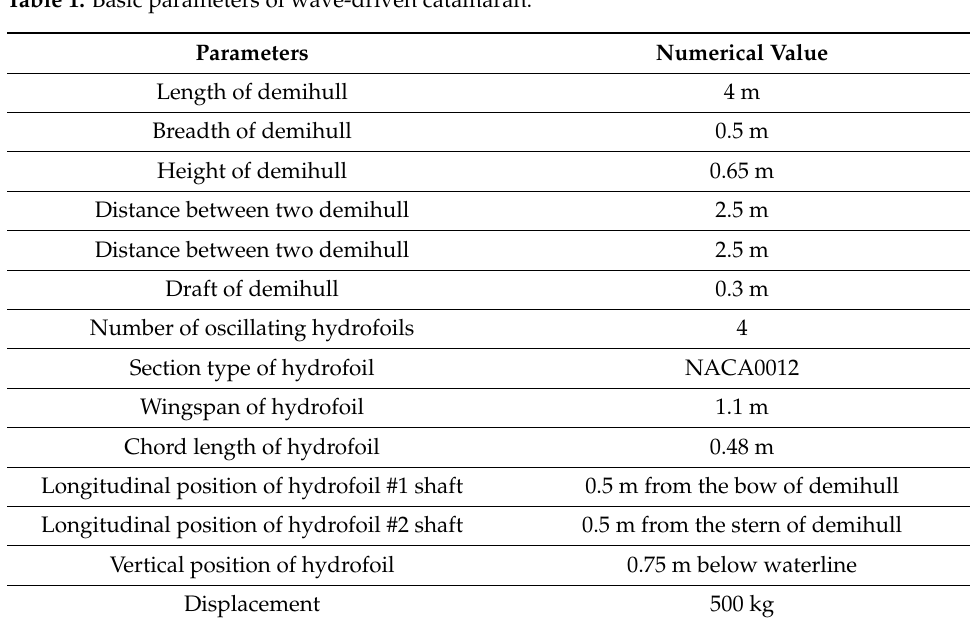
Figure 1. Three-dimensional model of wave-driven catamaran. Table 1. Basic parameters of wave-driven